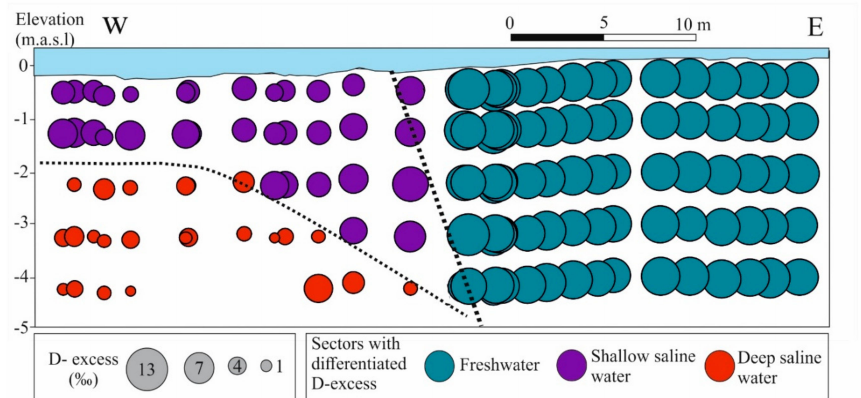
Figure 4. Deuterium excess along the cross-section with dashed lines dividing data into a freshwater zone, a shallow zone, and a deep saline zone, as explained in the text (vertical scale × 2.5). Stable isotopes of water ( δ 18 O and δ D) in groundwater showed alignment with the Global Meteoric Water Line (GMWL) and the Local Meteoric Water Line (LMWL) [50].